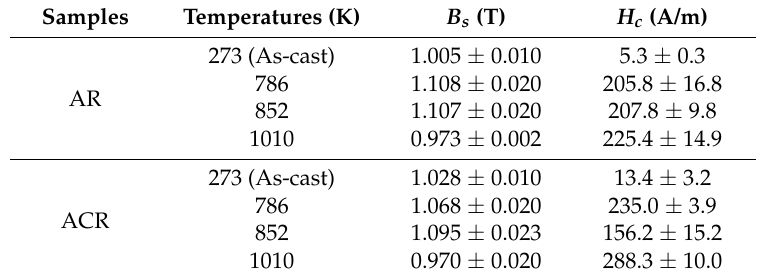
Table 1. B s and H c of the as-quenched AR and ACR ribbons and samples heated at different temperatures. Samples Temperatures